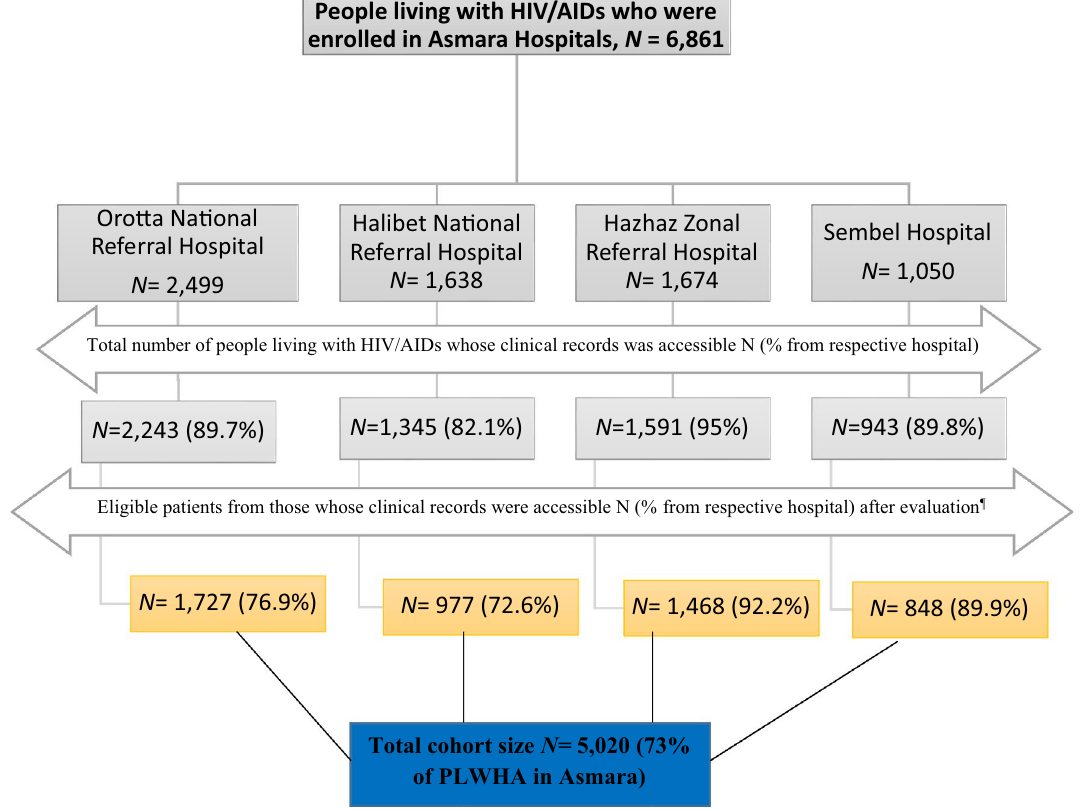
Figure 1. Flow diagram for study participants’ recruitment in PLWHA in Asmara Hospitals,